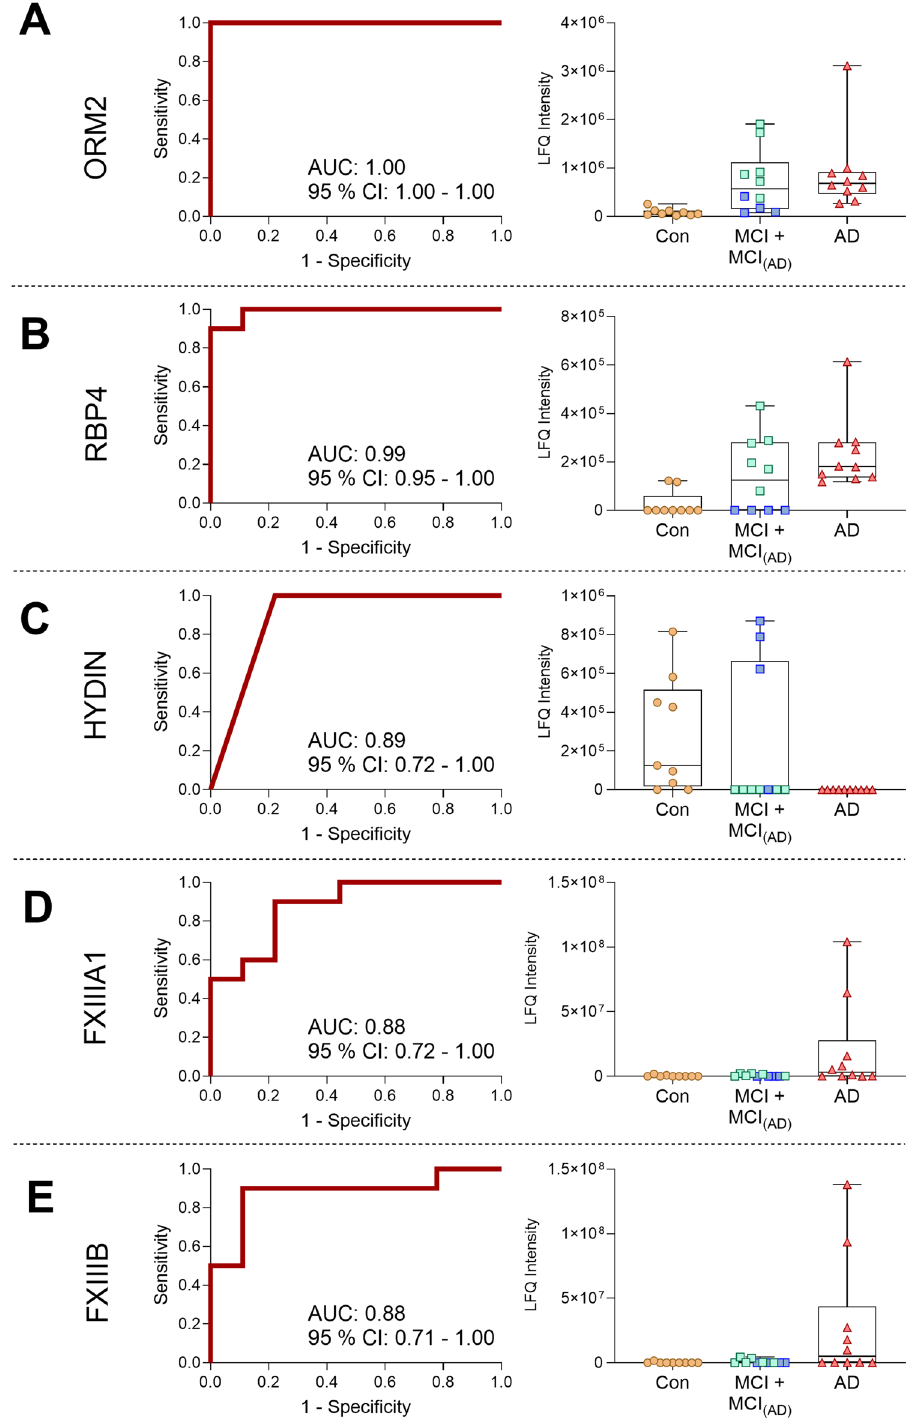
Figure 6. Receiver operating characteristic (ROC) curves and their corresponding boxplots of protein biomarker candidates for AD. ( A ) Orosomucoid 2 ( ORM2 ). ( B ) Retinol binding protein 4 ( RBP4 ). ( C ) Hydrocephalus-inducing protein homolog ( HYDIN ). ( D ) Coagulation factor 13 A1 ( FXIIIA1 ). ( E ) Coagulation factor 13 B ( FXIIIB ). Boxplots show non-logarithmic label free quantification (LFQ) intensities and include NaN values arbitrarily set to 0. Both subpopulations of the MCI group are indicated in the boxplots with MCI (AD) group marked with green